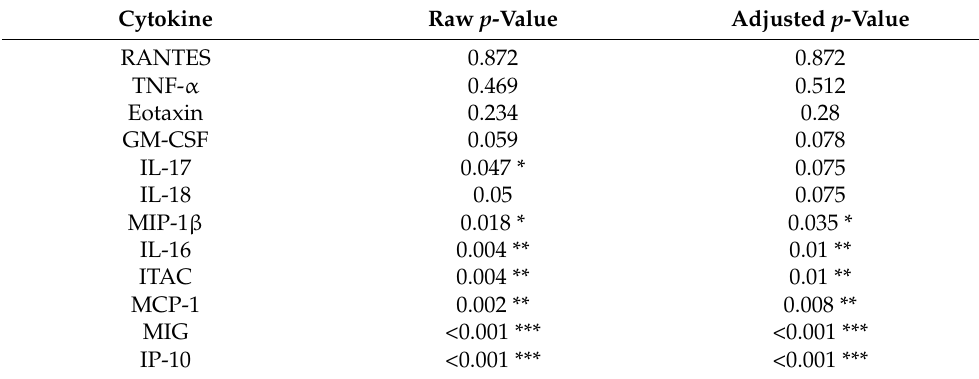
Table 4. Results from Wilcoxon rank-sum test: people with and without HIV.